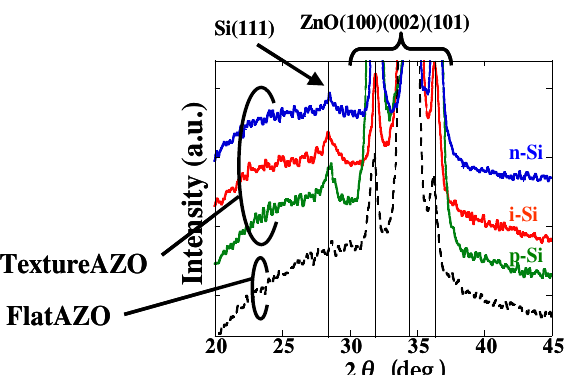
Fig. 5. GI-XRD patterns of TPJ-annealed 30-nm-thick n + -, p + -, and intrinsic- crystallized Si films on textured AZO-coated glass substrates after TPJ annealing at a T max of 825 ◦ C. The result of intrinsic- crystallized Si on flat AZO is also shown as a reference.